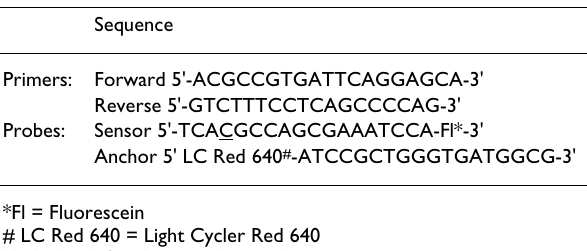
Table 1: Primers and hybridization probes used for COMT Val158Met genotyping